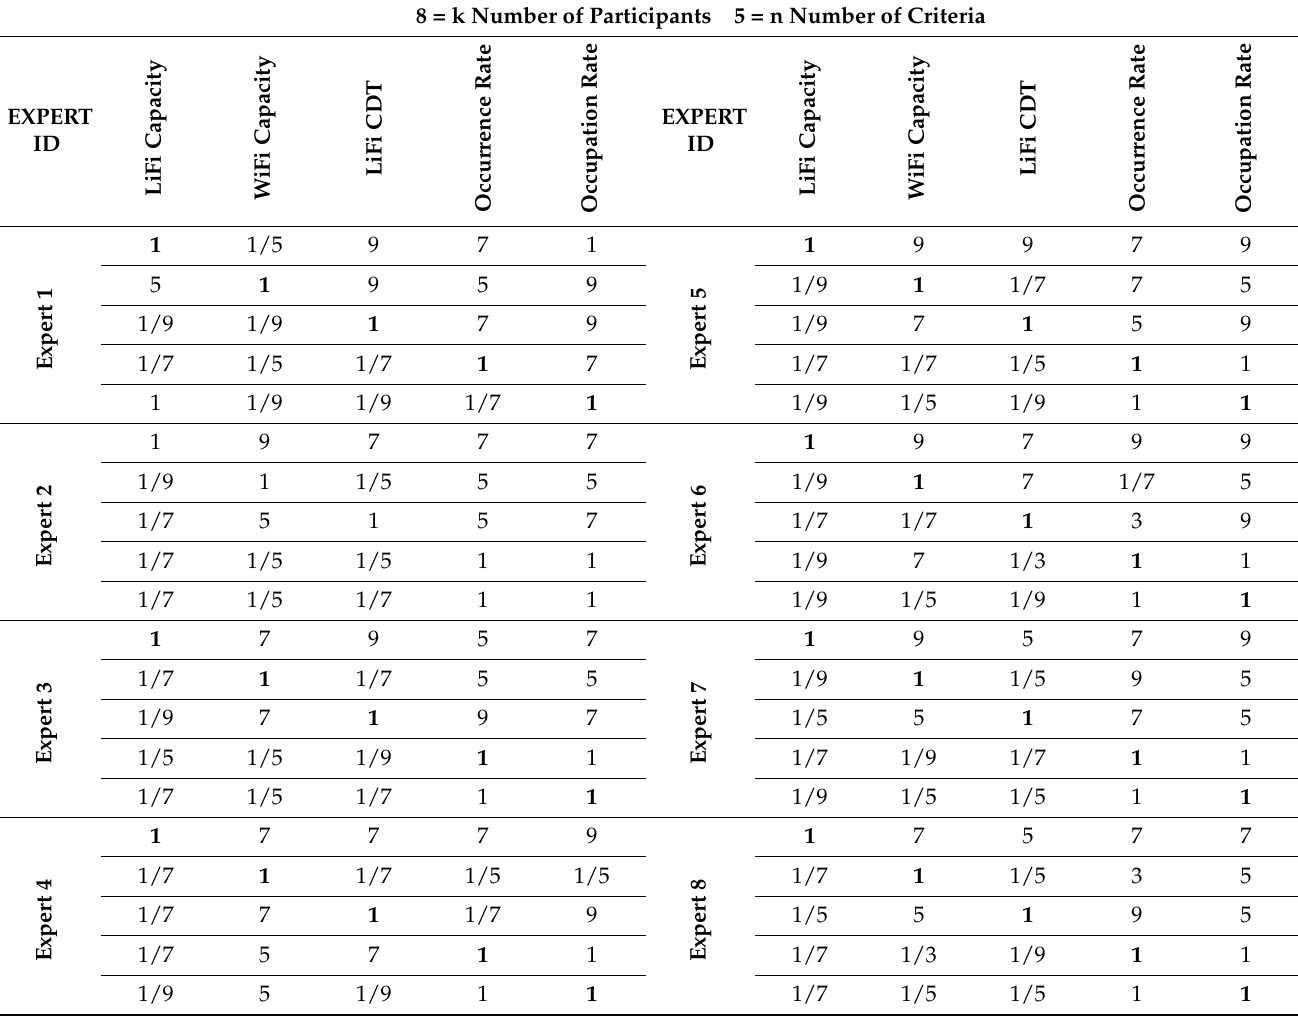
Table 16. PCM for each expert of all criteria and the CM for all participants. 8 = k Number of Participants 5 = n Number of Criteria